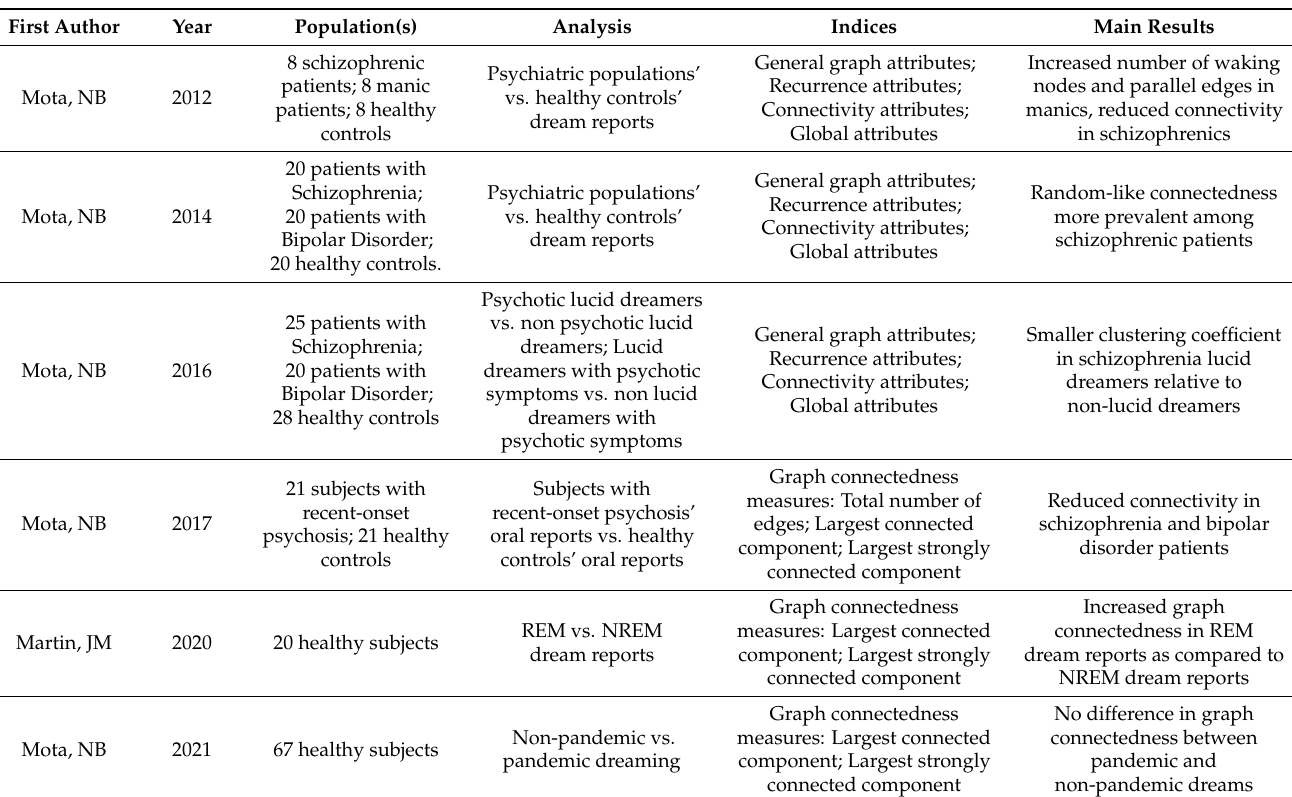
Table 2. Overview of studies using graph analysis to assess structural properties of dream reports (described in Section